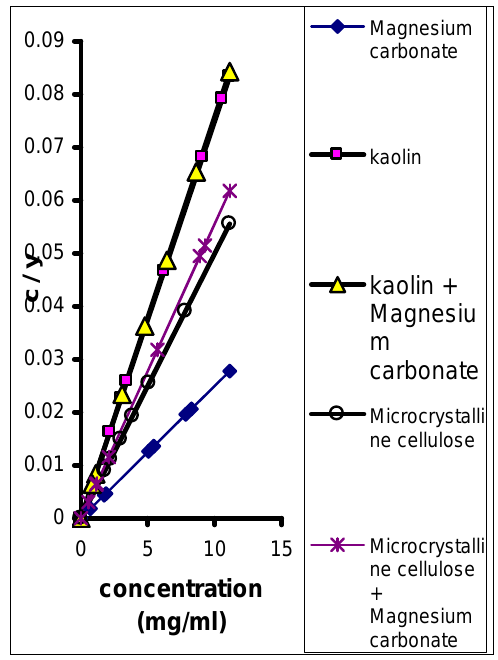
Figure 10: The percent of alpha-tocopherol acetate released from adsorbents mixture of kaolin and magnesium carbonate at pH 1.2 after 3 months of incubation period.